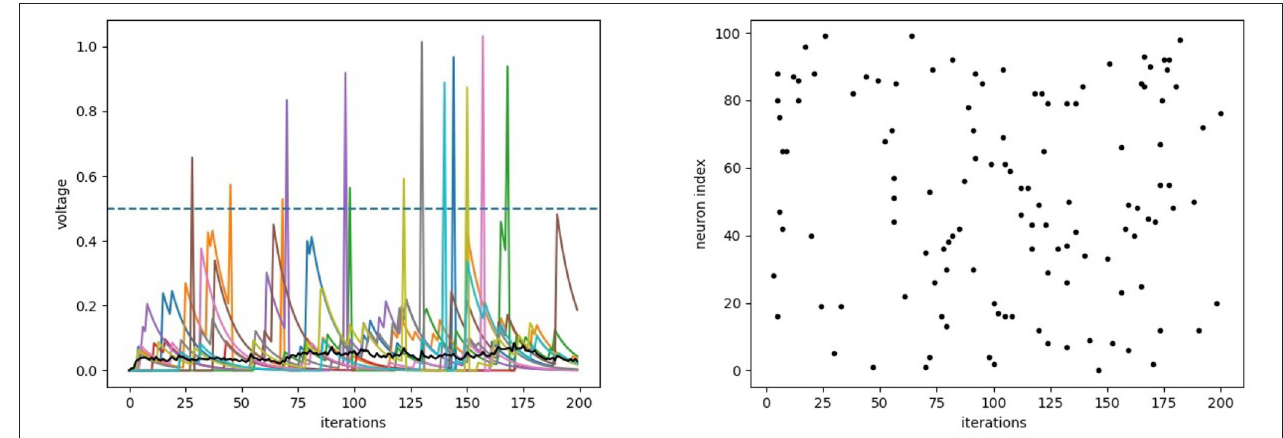
FIGURE 5 | The output of the plotting code block 4 (with additional axis labels), where the neurons receive random input from the Basic_Behaviour and additional input from other neurons through the Input_Behaviour . (Left) The individual voltage traces of the first 10 neurons are plotted with different colors, the mean voltage in black and the (constant) firing threshold with dashed lines. (Right) Raster plot showing spikes (black dots) of all neurons during the same period.